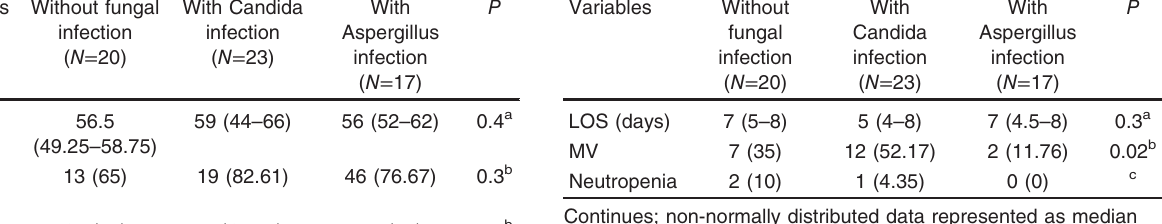
Table 2 Demographic characteristics in correlation with fungal infection Variables Without fungal infection